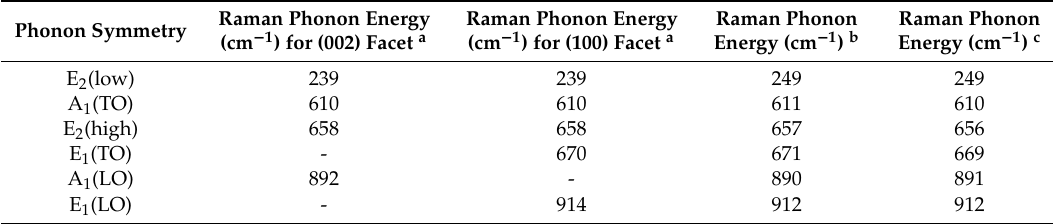
Table 2. Raman phonon energies (cm − 1 ) of the prepared AlN at room temperature. Phonon